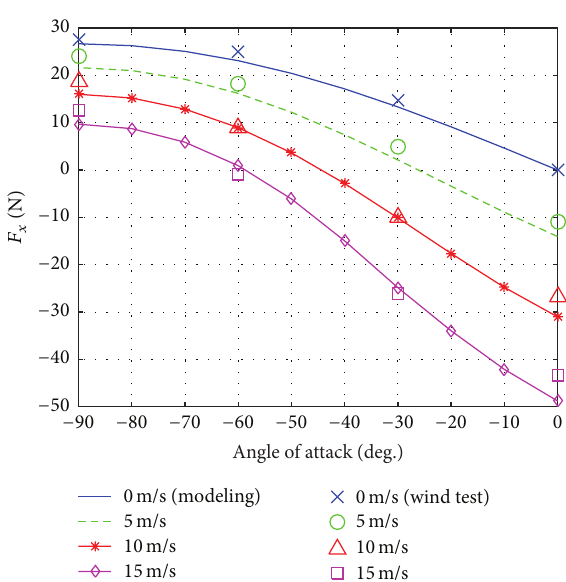
Figure 6: Comparison of total force on 𝑥 -axis.